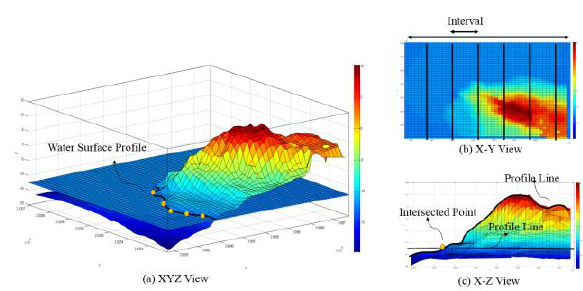
Figure 5: The water surface profile: (a) Water surface profile in 3D space (b) Choose interval in X-Y view; (c) Determine the intersected point of two